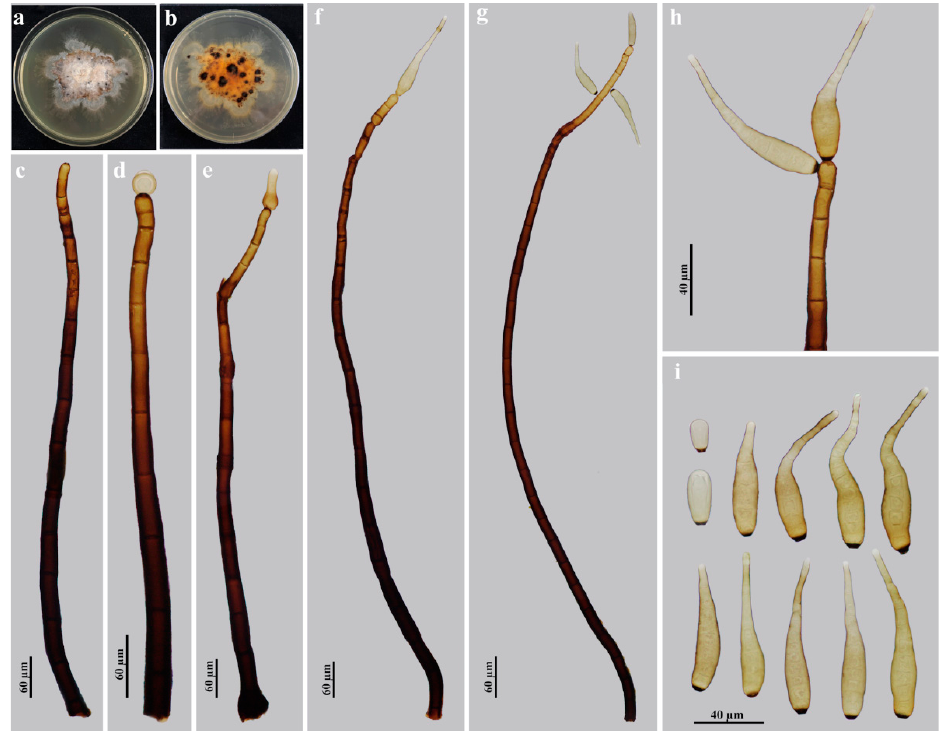
Figure 2. Helminthosporium guanshanense (HJAUP M1022, holotype): ( a ) surface of colony after 4 weeks on PDA; ( b ) reverse of colony after 4 weeks on PDA; ( c ) conidiophore and conidiogenous cells; ( d – g ) conidiophores, conidiogenous cells and conidia; ( h ) conidiogenous cells and conidia; ( i ) conidia. Description: Saprobic on dead branches in terrestrial habitats. Anamorph Indexfungorum number: hyphomycetous. Colonies on natural substrate effuse, scattered, hairy, brown to dark brown. Mycelium superficial and immersed in the substratum, composed of branched, septate, smooth, pale brown to brown, thick-walled hyphae. Conidiophores